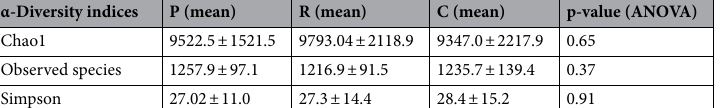
Table 4. OTU-based diversity indexes in salivary samples of the experimental groups of subjects. The table shows the total number of OTUs, (b) Chao index and (c) Simpson’s evenness indexes in CFS patients, patients’ relatives and external control group respectively. Univariate (ANOVA) test is applied in order to assess significant differences between groups (p < 0.05). P CFS/ME patients, R patients’ relatives, C external control